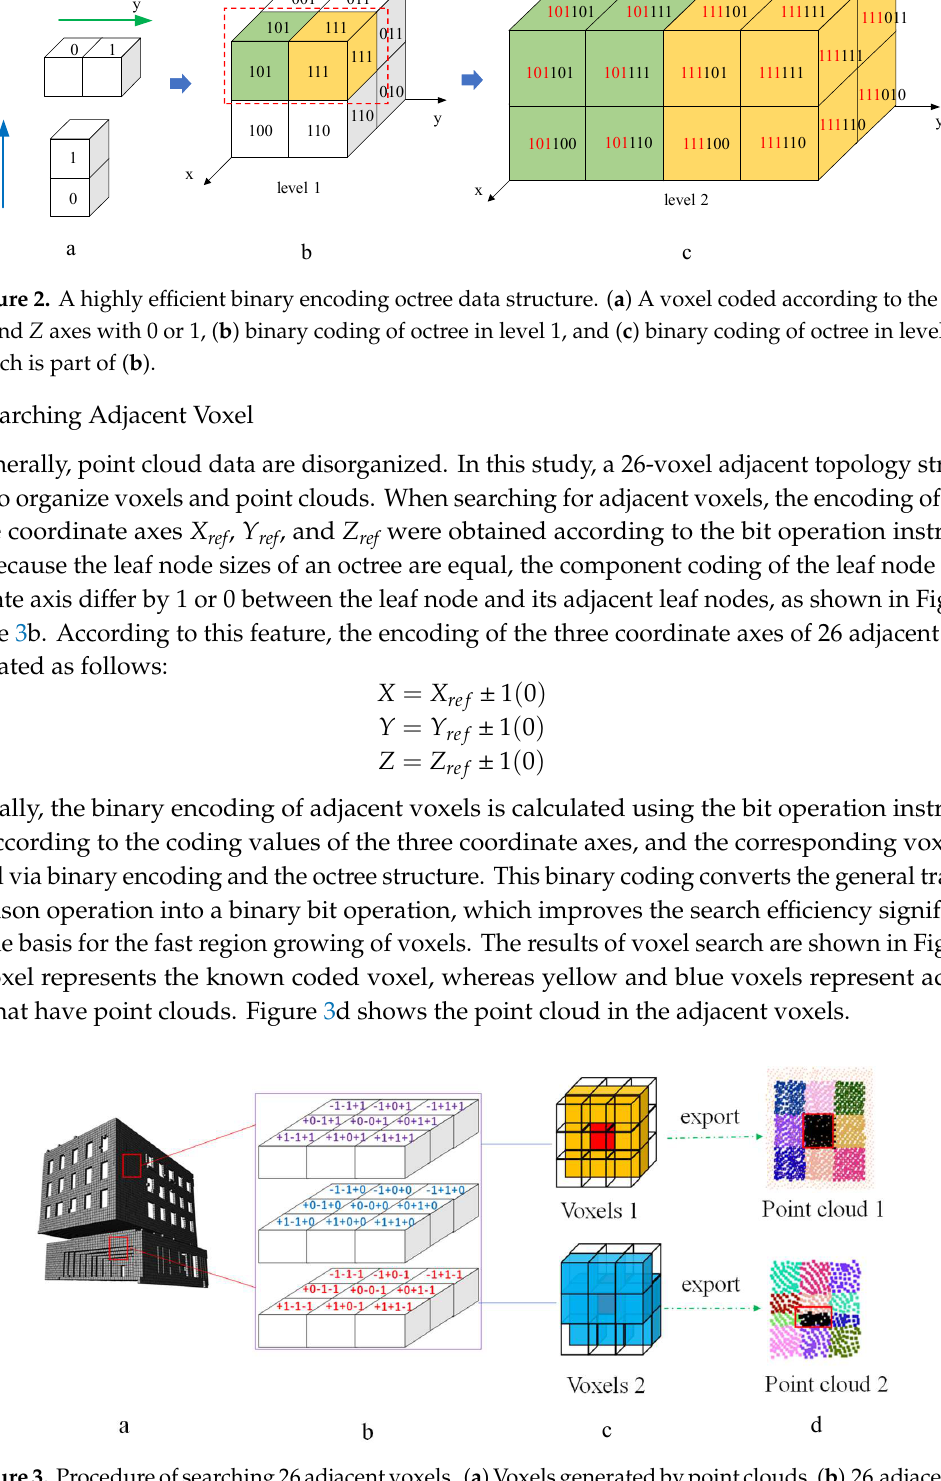
Figure 3. Procedure of searching 26 adjacent voxels. ( a ) Voxels generated by point clouds, ( b ) 26 adjacent voxels, ( c ) adjacent voxel search results, and ( d ) point cloud in adjacent voxels.